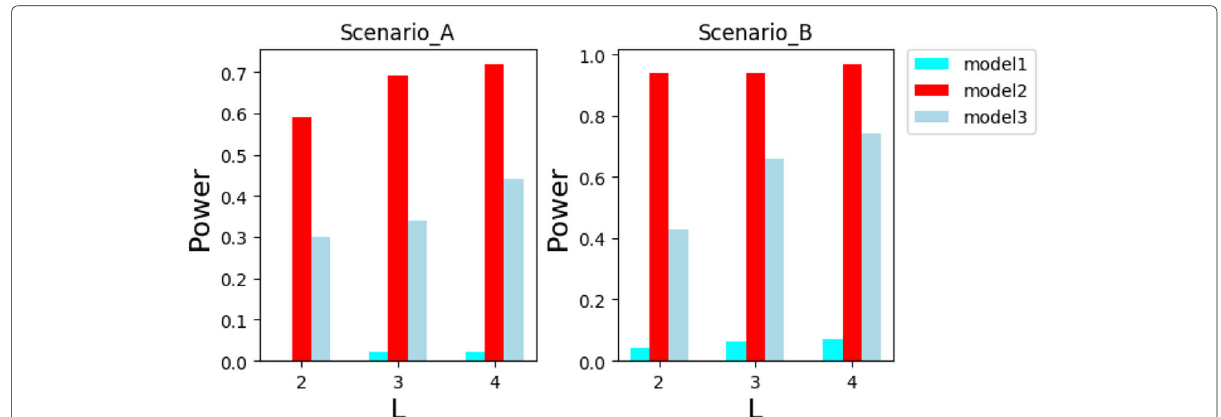
Fig. 3 050301( MAF = 0.5, λ = 0.3, r 2 =